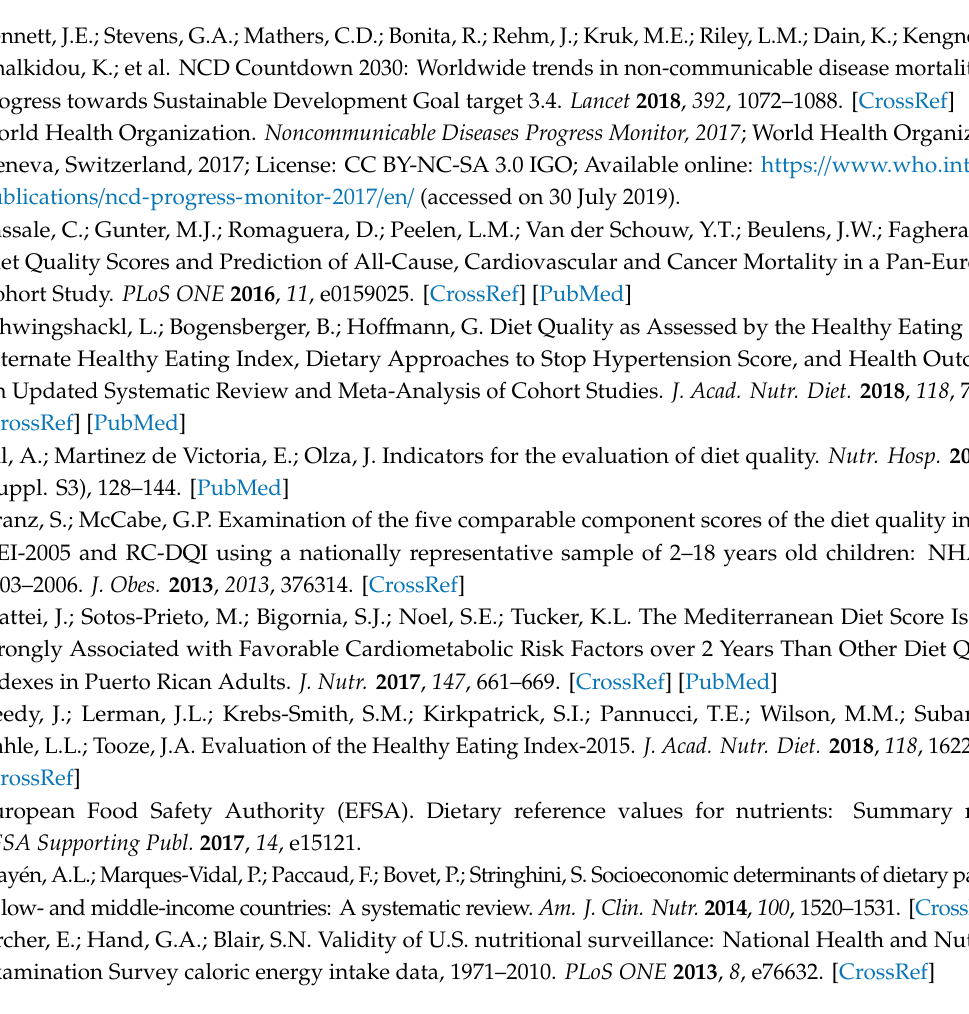
Table S1: Percentage of the ANIBES population for each diet quality index (DQI) stratified by education and income levels, Table S2: Major estimated e ff ects of education and income on the degree of diet quality for each DQI based on ordinal regression general linear models, Table S3: Percentage of the ANIBES population (AP) and the plausible energy reporters (PER) for each diet quality index